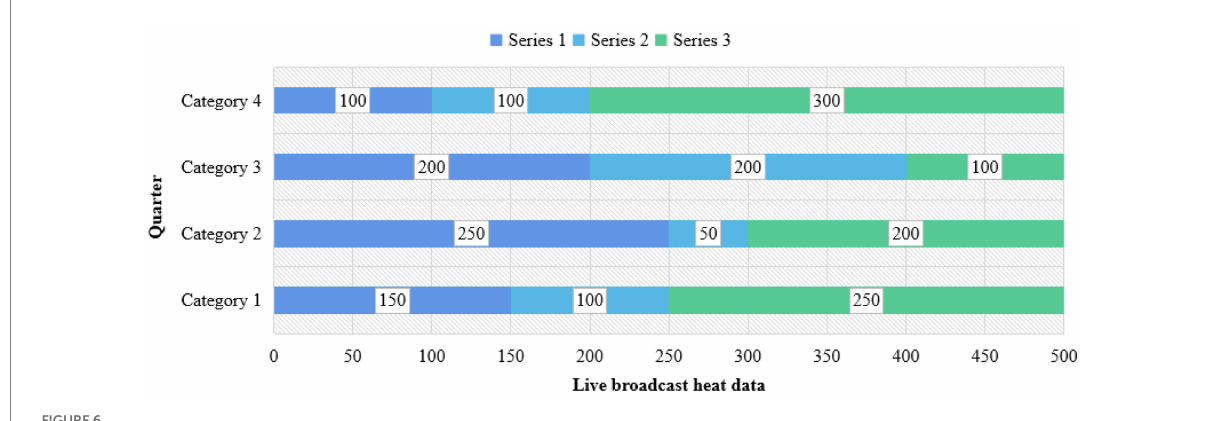
FIGURE 6 Data map of live delivery marketing